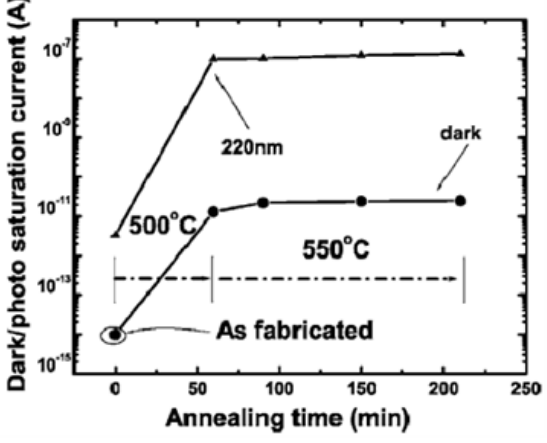
Figure 19. Dependence of the saturated dark current and photocurrent of the diamond photodiode under 220 nm light illumination with an intensity of 26 µW/cm 2 at a reverse bias of 20 V on the annealing temperatures and times. (Reprinted from Reference